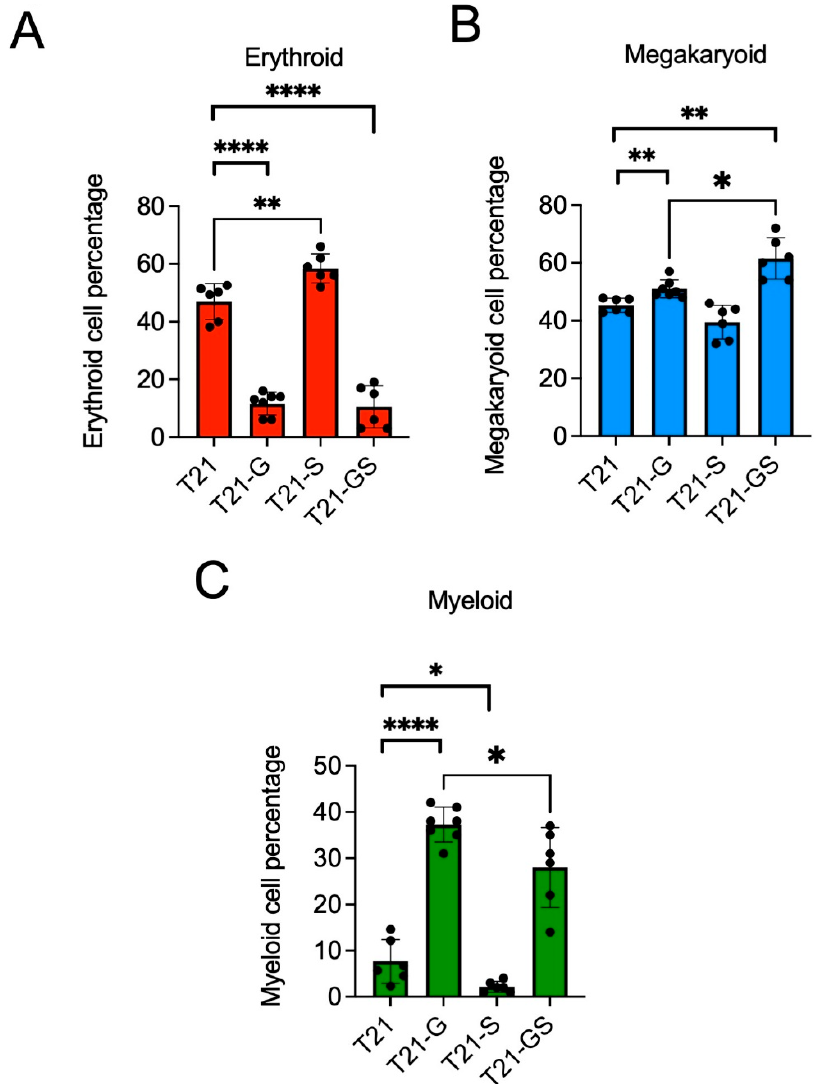
Figure 2. Graphs show the percentage of erythroid ( A ), megakaryoid ( B ), and myeloid ( C ) populations in HSPCs generated from two distinct iPSC lines with or without GATA1 and/or STAG2 mutation. Data combined from both iPSC lines performed in 3–4 independent experiments per iPSC line is plotted. Error bars indicate SD of the mean. Asterisk indicates statistical significance in indicated pair of iPSC lines, * p < 0.05, ** p < 0.01, **** p < 0.0001. Data from each iPSC line are presented in Figure S1.